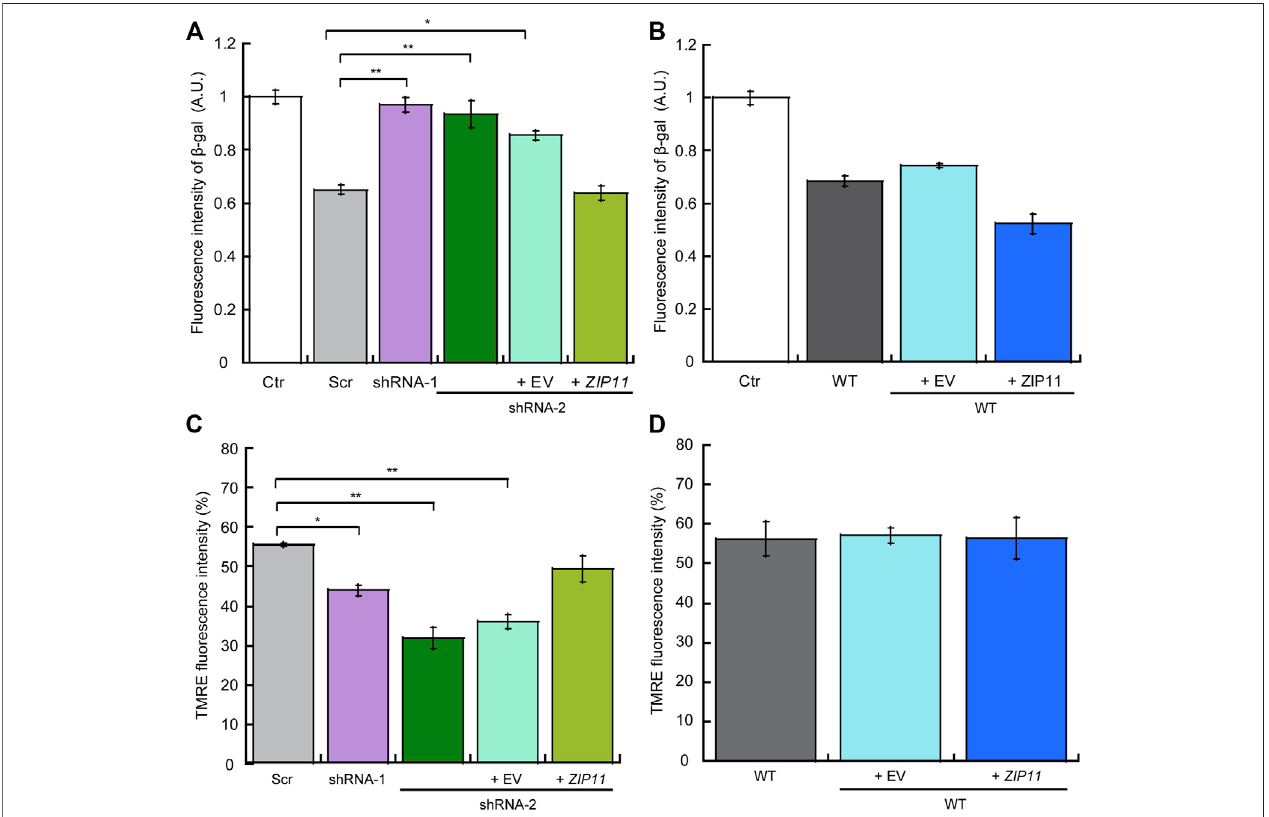
FIGURE 10 | Knockdown of ZIP11 induces a senescent state which correlates with decreased mitochondrial potential in HeLa cells. Detection of cellular senescence via activationof β -galactosidasehydrolysis,amarkerforsenescentcells,inScr, ZIP11 KDcellsandreconstitutedwithexogenous ZIP11 (A) orwildtypecells over expressing the transporter (B) . WT HeLa cells treated with 5 mM Palbociclib were used as a positive control for senescence (Ctr). Data was normalized to Palbociclib treated cells. Mitochondrial membrane potential was measured by staining cells KD for ZIP11, reconstituted (C) or overexpressing (D) the exogenous gene with 200 nM TMRE and the percentage of fl uorescence intensity of three independent biological replicates was plotted. Data show means ± SE of three independent biological replicates imaged. * p < 0.05, ** p < 0.01 relative to